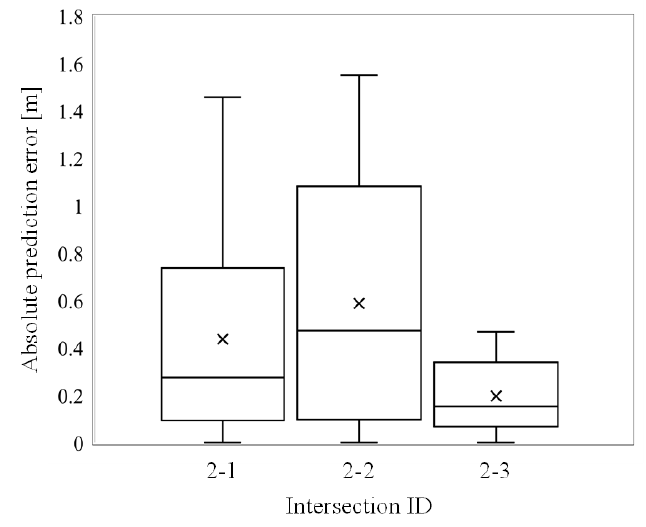
Figure 14. The box plot of the absolute prediction errors in each target intersection. Seventy-five percent of absolute errors in all cases were less than 1.2 m, and especially in intersection ID 2-3, the 75% of prediction errors were less than 0.4 m. In addition, 50% of absolute errors in all cases were less than 0.5